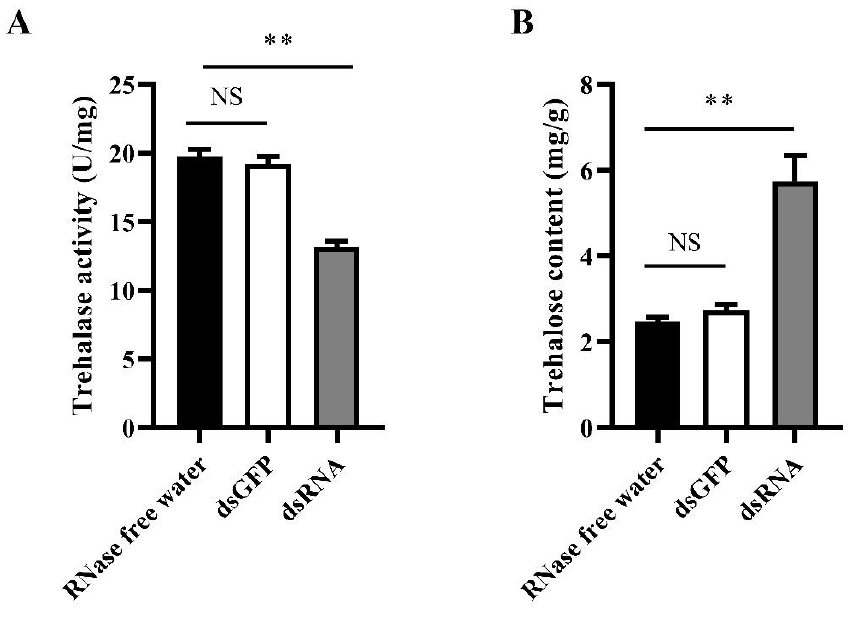
Figure 11. Detection of enzyme activity and trehalase content after RNAi treatment. ( A ) Trehalase activity after RNAi treatment. ( B ) Trehalose content after RNAi treatment. All data obtained were expressed as the means ± standard deviations of three replicates and were tested using a one-way ANOVA and t tests using SPSS 22.0. The standard deviation of the computed means based on three biological replicates is represented by the error bars. No significant differences are indicated by NS. The significant differences are indicated by ** ( p <